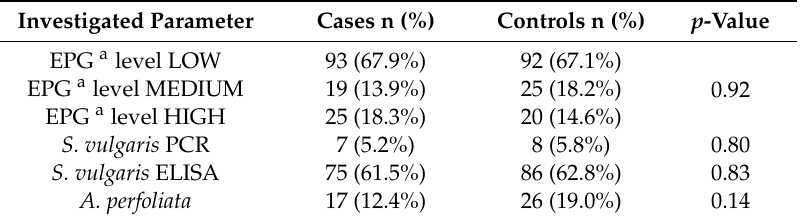
Table 6. Fecal and serology results in cases and controls. The p -value for statistical significance was corrected for the number of analyses (n = 4) according to Bonferroni, i.e., p < 0.01 (0.05 /